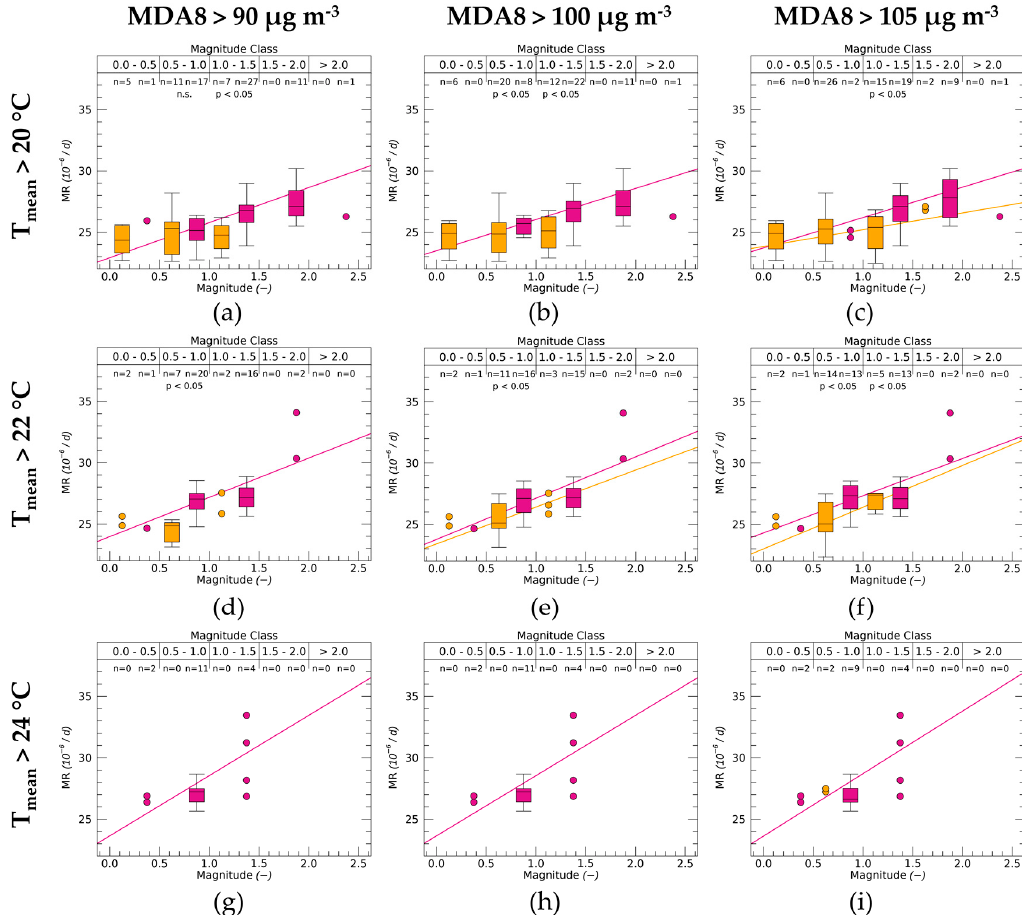
Figure 6. Comparison of HEs (yellow bars) and HEc (purple bars) with T mean as the predictor variable ( x -axis) for daily mortality rates ( y -axis) for di ff erent threshold combinations (( a ) T mean > 20 ◦ C, MDA8 > 90 µ g m − 3 ; ( b ) T mean > 20 ◦ C, MDA8 > 100 µ g m − 3 ; ( c ) T mean > 20 ◦ C, MDA8 > 105 µ g m − 3 ; ( d ) T mean > 22 ◦ C, MDA8 > 90 µ g m − 3 ; ( e ) T mean > 22 ◦ C, MDA8 > 100 µ g m − 3 ; ( f ) T mean > 22 ◦